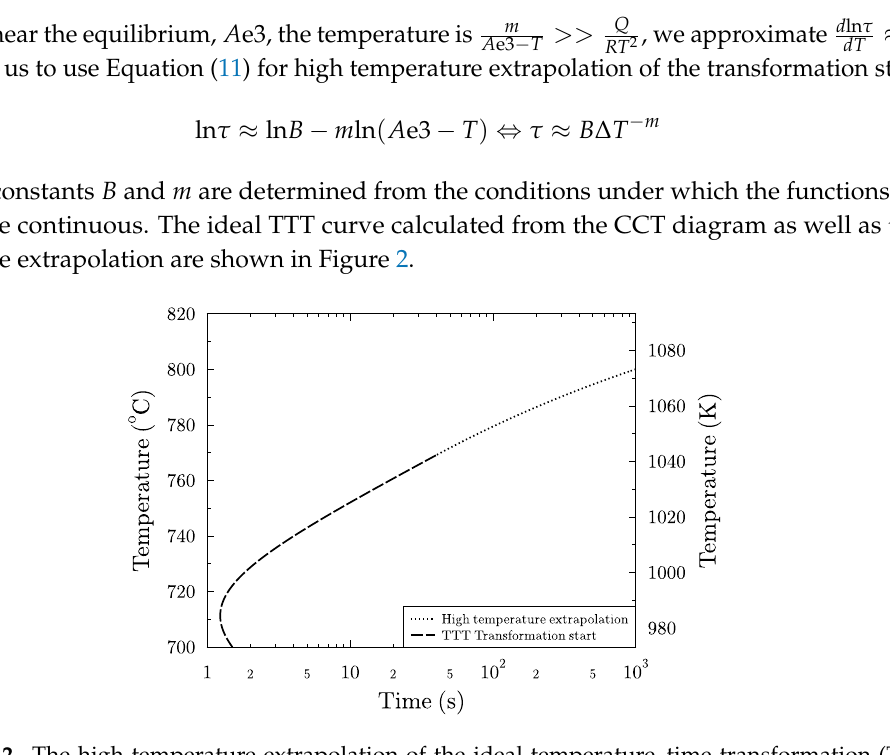
Figure 2. The high temperature extrapolation of the ideal temperature–time transformation (TTT curve), calculated using Equation (11), shown together with the ideal TTT start diagram calculated directly from the experimentally fitted CCT curve using Equation